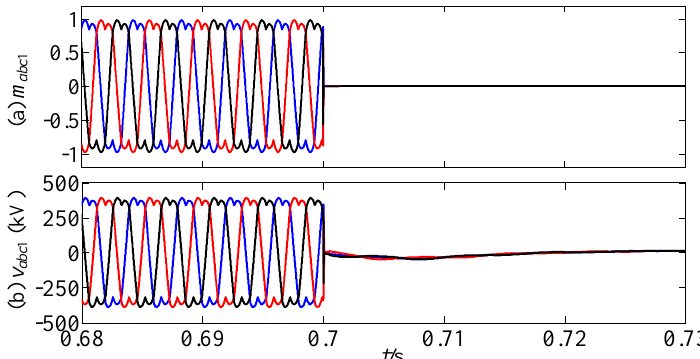
Figure 3. AC quantities of the DC/DC converter in the proposed standby operation in the event of a local DC fault at t 0 = 0.7 s: ( a ) three-phase modulation waveforms and ( b ) three-phase output